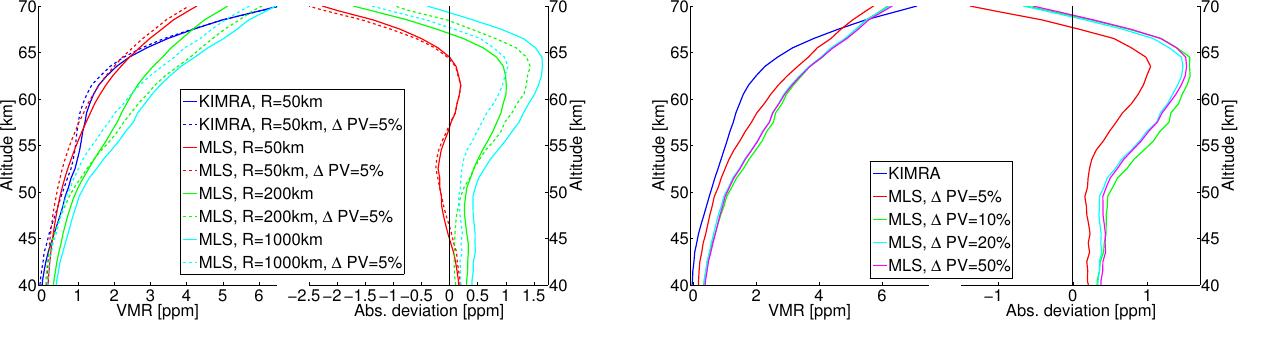
Fig. 11. Investigation of the influence of the collocation area using the MLS dataset. In the first case (solid lines) only the area criterion with different radii R was applied. In the second case (dashed lines) a PV threshold of 1 PV=5% was additionally applied. Left panel: mean profiles derived according to Sect. 5.1. KIMRA profiles are only shown for the tightest collocation criteria since their sensitivity to a criterion change is low (a dependency only exists, if the aver- aged period changes as result of a criterion change). Right panel: deviation between the KIMRA and the satellite profiles calculated with Eq. (20).